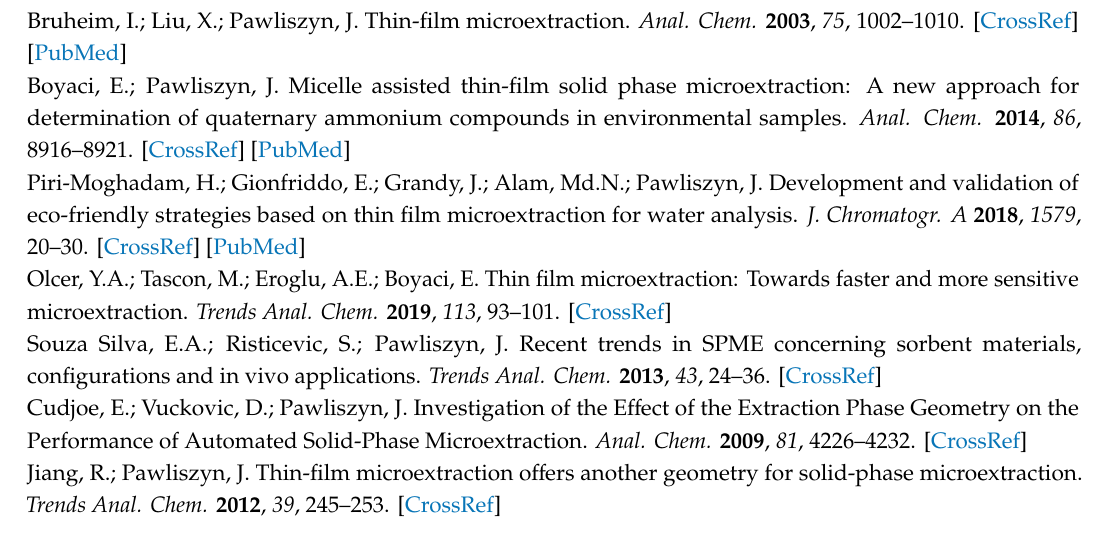
Table S3: Normalized extraction e ffi ciency of each analyte from eight thin-film coatings at various pH values. Extractions were performed in triplicate at pH 3.0, 7.4 and 10.0, using an extraction time of 2 h. Desorption was performed for 1 h using desorption solvent 2. Table S4: Physicochemical properties and suppliers of LC analytes for coating evaluation. Table S5: The ratio of adsorbent and PAN glue for each coating. Table S6: Optimized mass spectrometry conditions for all the analytes in API 4000 mass spectrometer. Table S7: Summary of optimized LC-MS / MS